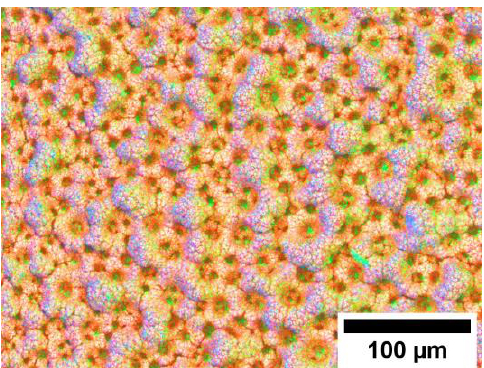
Figure 9. Image of EDS mapping of modified Co foam, using CV at 100 mV/s scan rate and after 100 cycles. Red color represents cobalt, green – iron, blue – carbon.